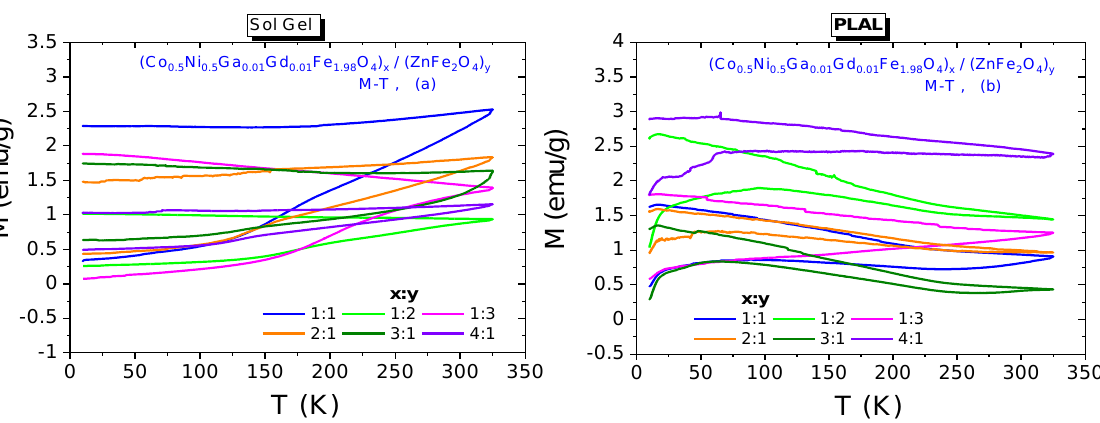
Figure 12. Temperature dependence of ZFC and FC magnetizations for (Co 0.5 Ni 0.5 Ga 0.01 Gd 0.01 Fe 1.98 O 4 ) x /(ZnFe 2 O 4 ) y NCs synthesized by ( a ) sol-gel method and ( b ) laser ablation method, respectively.